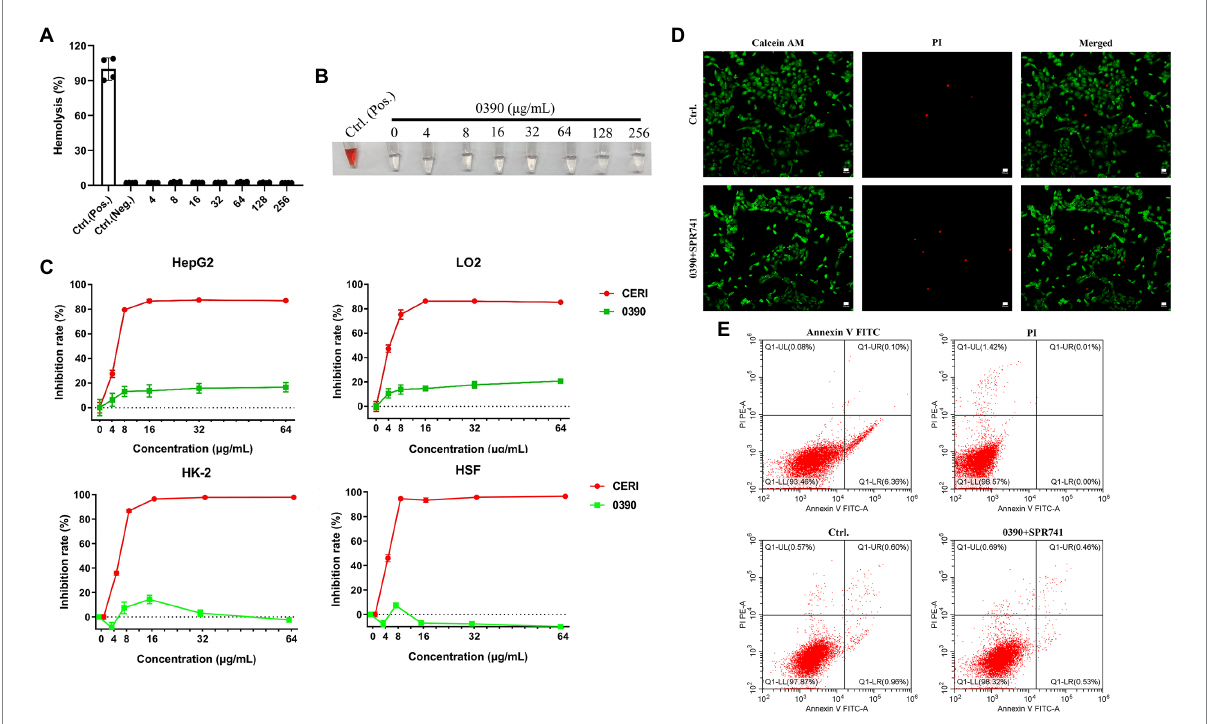
FIGURE 5 Hemolytic activity and cytotoxicity of 0390 alone or in combination with SPR741. Human RBCs hemolysis rates (A) and representative images (B) in the presence of a series concentrations of 0390, 0.1% DMSO (negative control), or 0.1% Triton X-100 (positive control). (C) The cytotoxicity of 0390 and CERI (positive control) to HepG2 (human hepatocarcinoma cell line), LO2 (human normal hepatocyte cell line), HK-2 (human kidney tubule epithelial cell line), and HSF (human skin fibroblast cell line) were evaluated by CCK-8 assays. (D) CLSM images of HK-2 cells stained by calcein-AM/PI after being treated with 0390 alone or in combination with SPR741. Green indicates live cells and red indicates dead cells. Scale: